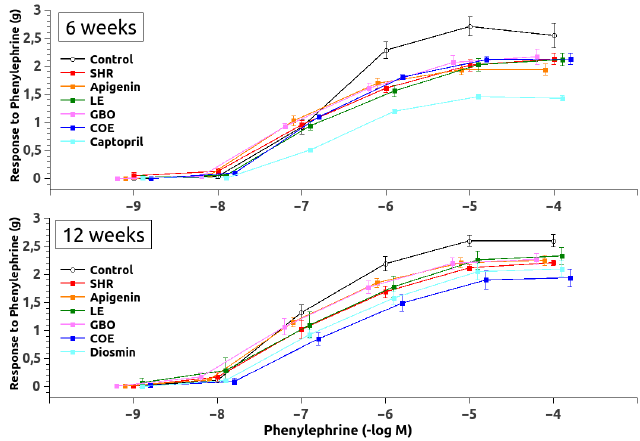
Figure 2. Pressor response to phenylephrine in aortic rings. Abbreviations: SHR (spontaneously hypertensive rats), LE (lemon extract), GBO (Grapefruit + bitter orange extract), and COE (cocoa extract).